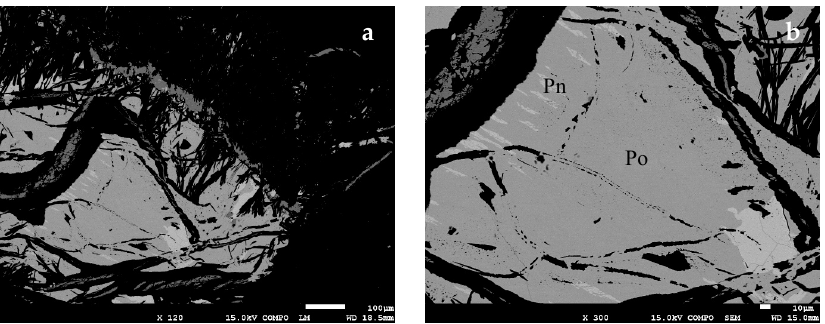
Figure 3. ( a ) Flames of pentlandite in a pyrrhotite grain, Raglan sample; ( b ) Zoom on the flames of pentlandite (Pn) in pyrrhotite (Po).